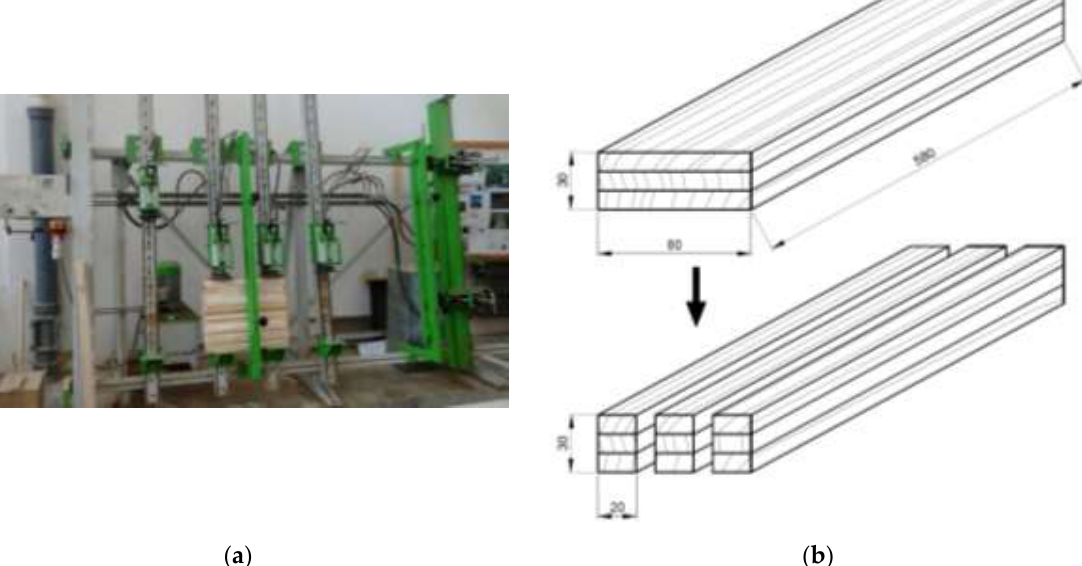
Figure 2. Pressing of wide pre-lamellas (580 mm × 80 mm × 10 mm) coated with PUR glue into three-layer glulam composites (580 mm × 80 mm × 30 mm) ( a ); preparation of the three-layer glu- lam beams (580 mm × 20 mm × 30 mm) from the composite ( b